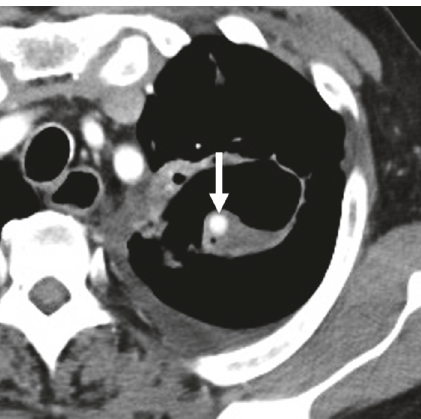
Figure 1: Contrast-enhanced axial computed tomography image. There is a 7mm round aneurysm (arrow) within a cavitary lesion in the left upper lobe of the lung.